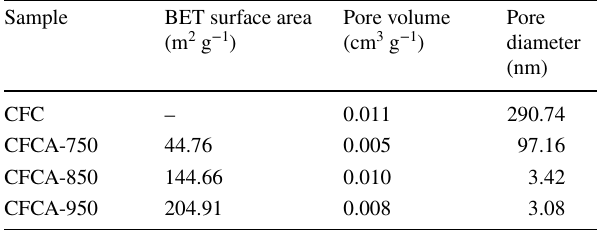
D / I G ratio and surface crystalline size of